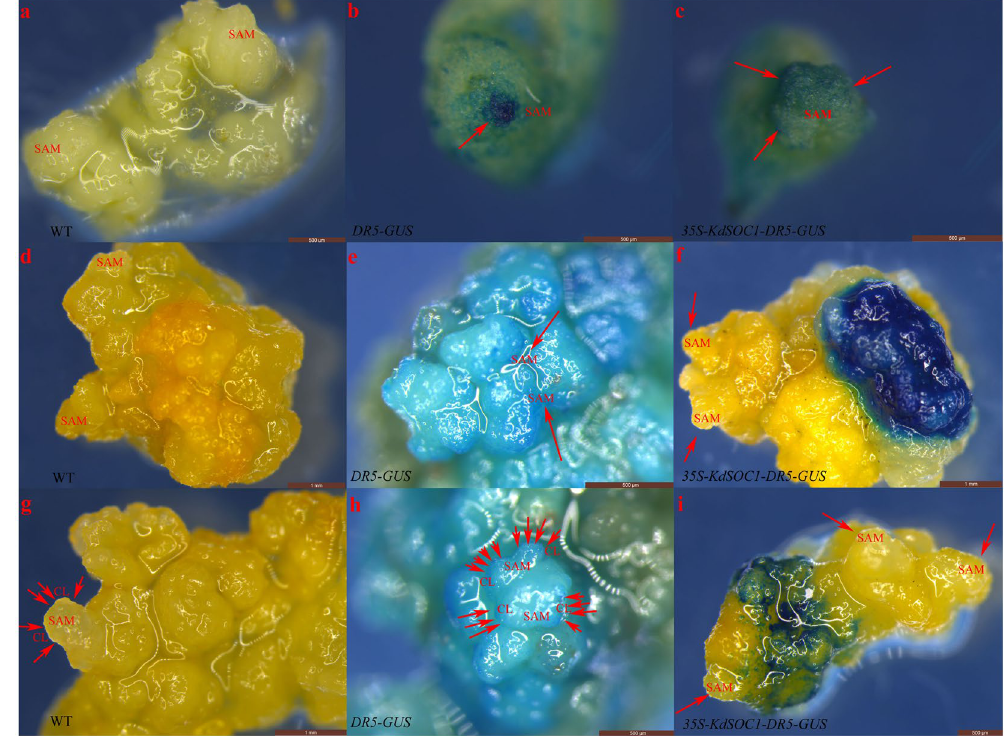
Figure 7. Over-expression of KdSOC1 gene disturbed the auxin flow during Arabidopsis embryogenesis. ( a – c ) Early globular stage of Arabidopsis somatic embryogenesis. ( d–f ) Early heart stage of Arabidopsis somatic embryogenesis. ( g–i ) Torpedo stage of Arabidopsis somatic embryogenesis. Red arrow indicated the high auxin concentration site and white arrow indicated the missing auxin concentration site. SAM: shoot apical meristem, CL: